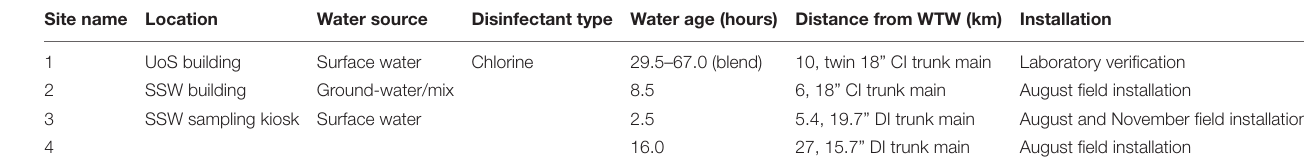
TABLE 1 | Summary of the key features of the sites used for investigation into the impact of water quality on the biofouling rate. Site name